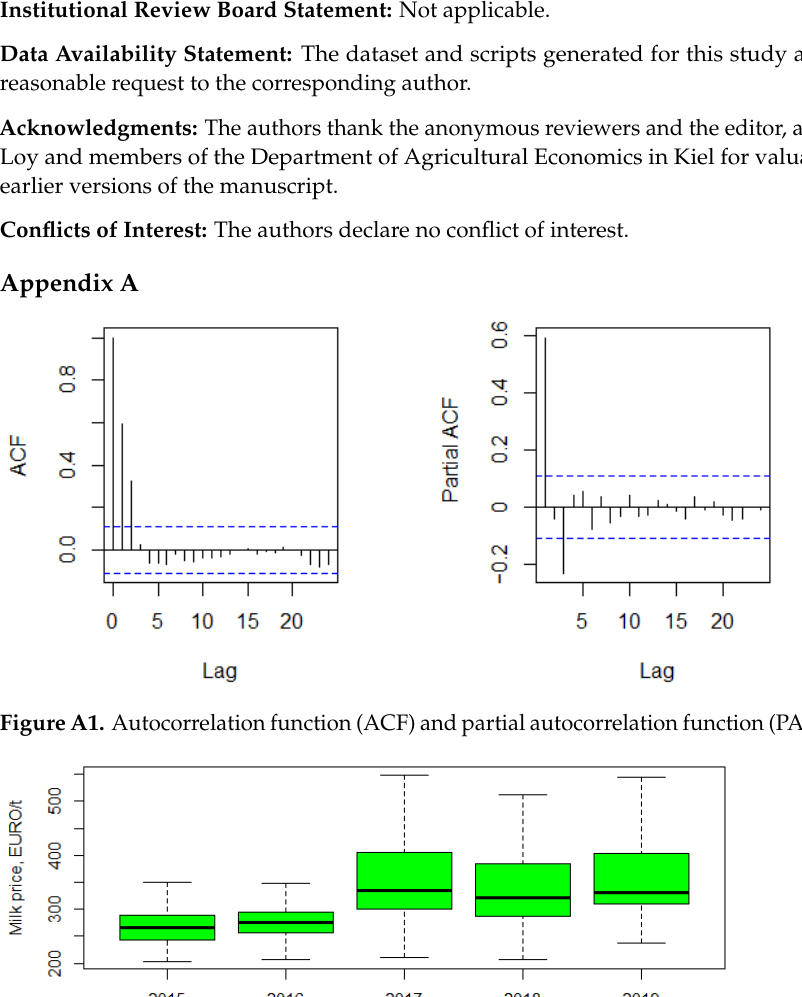
Figure A3. Correlation plot for all 17 collected explanatory variables Red color in the correlation plot indicates the correlation coefficients greater than zero; blue color indicates the correlation coefficients smaller than zero). Figure A4. Prediction root mean square errors (RMSE) for different years in the test dataset.